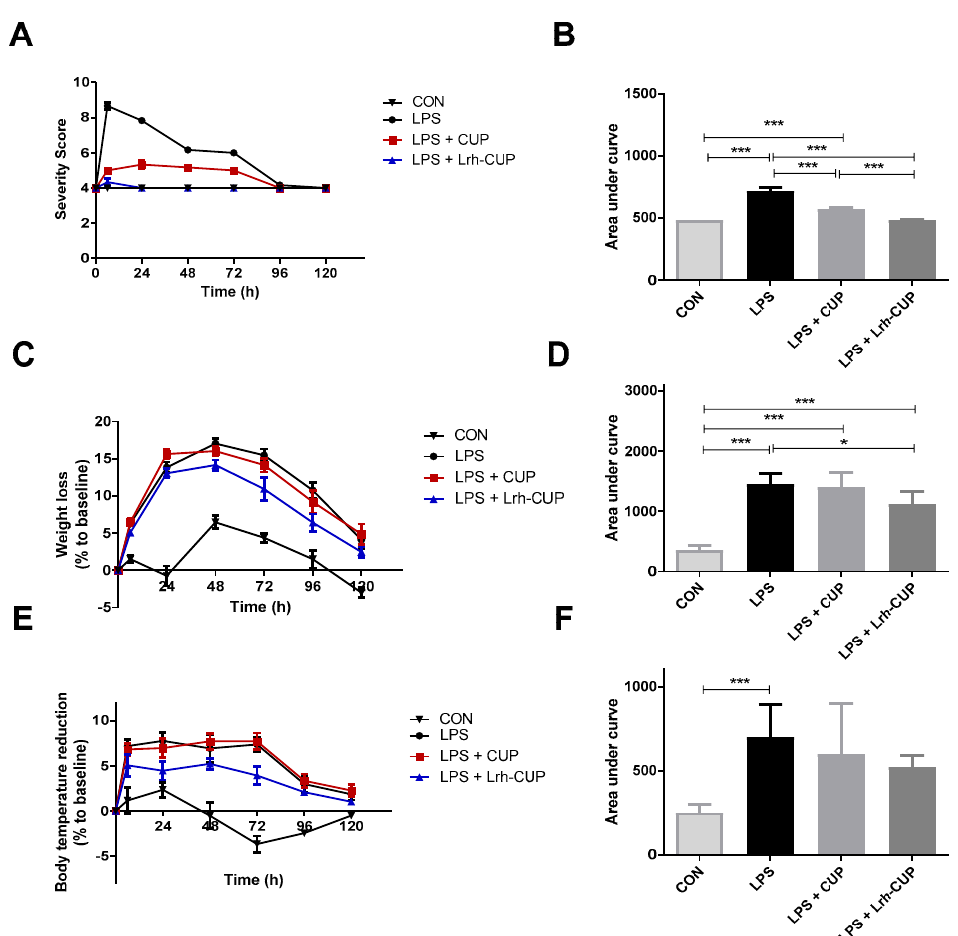
Figure 3. Effects of fermented and unfermented Theobroma grandiflorum juice on some pathologic parameters associated with LPS-mediated endotoxemia. ( A ) Kinects of variation of severity score; ( B ) Area under curve from data of severity score analysis; ( C ) Kinects of variation of weight loss; ( D ) Area under curve from data of weight loss analysis; ( E ) Kinects of variation of body temperature reduction; ( F ) Area under curve from data of body temperature reduction analysis. * Significant differences with p < 0.05; *** Significant differences with p < 0.0001. LPS: mice submitted to LPS-mediated endotoxemia; LPS + CUP: mice treated with unfermented T. grandiflorum juice and submitted to LPS-mediated endotoxemia; LPS + Lrh-CUP: mice treated with L. rhamnosus -fermented T. grandiflorum juice and submitted to LPS-mediated